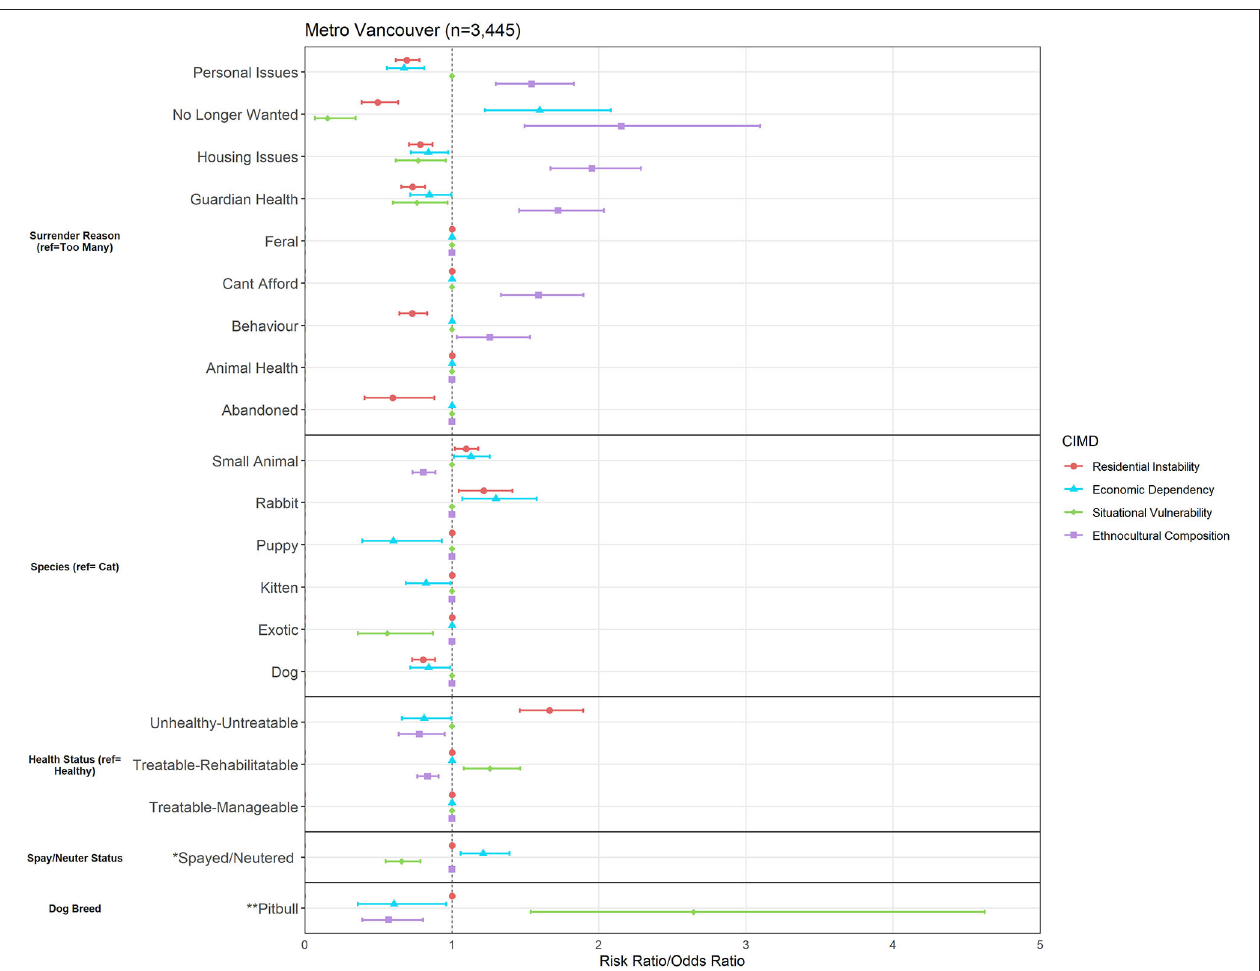
FIGURE 2 | Association between Canadian Index of Multiple Deprivation (CIMD) factors and owner surrender variables across the Metro Vancouver area ( n = 3,445). Results of logistic regression models for shelter variables by increasing CIMD factors are shown. Data are presented by risk ratios and their 95% confidence interval (bars); p < 0.05 when 95% confidence interval does not cross the vertical dotted line. Non-significant results are represented by a risk ratio of 1 with no CI. A risk ratio > 1 suggests an increased risk of that shelter variable category as you increase in deprivation, while a risk ratio < 1 suggests a reduced risk. *denotes data from dogs, cats, kittens, and puppies only ( n = 2,128) and is represented in odds ratios (and 95% CI). **denotes data from dogs and puppies only ( n = 609) and is represented in odds ratios (and 95%